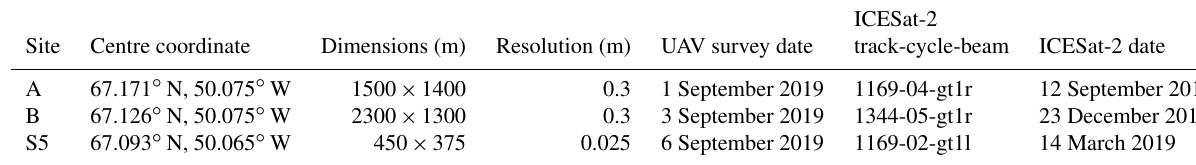
Table 2. Description of DEMs obtained by UAV photogrammetry and of the corresponding overlapping ICESat-2 laser beams.